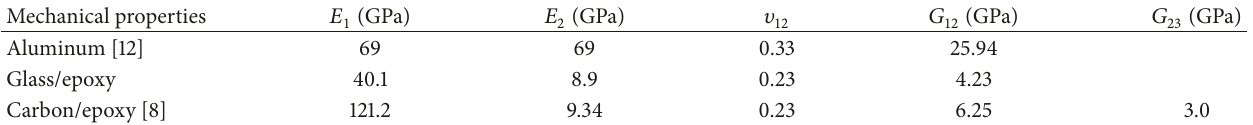
Table 3: Elastic constants obtained by the tensile test and